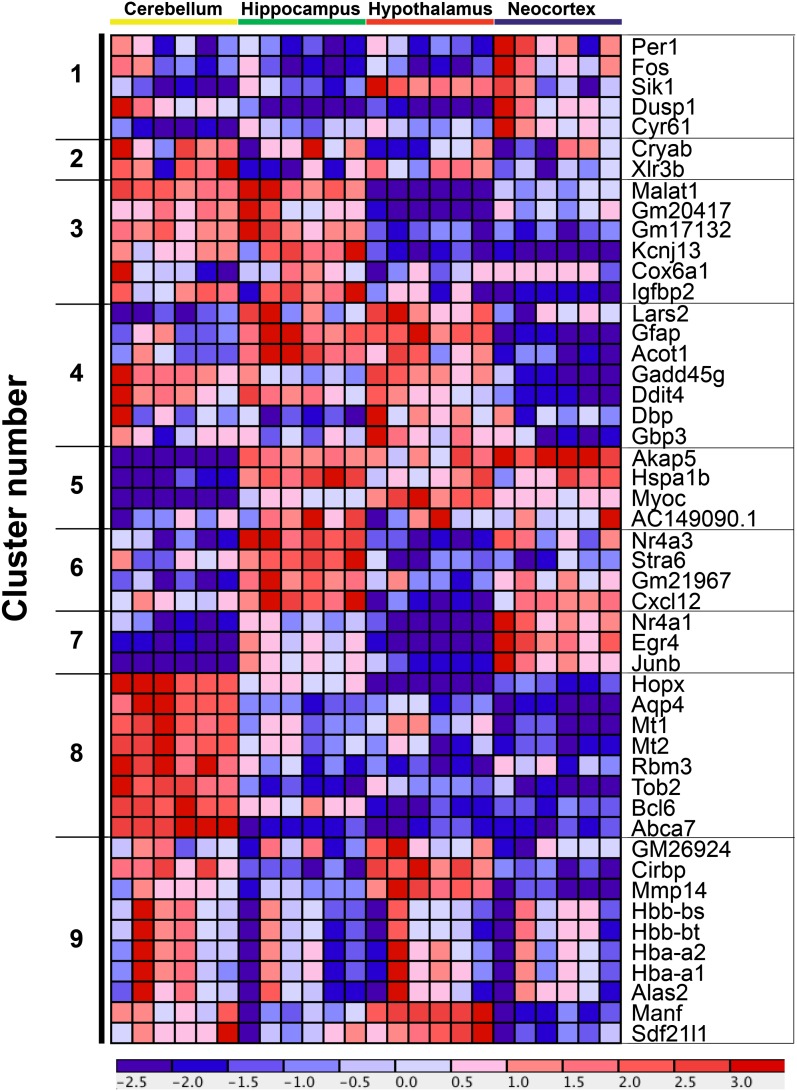
Expression pattern for the 49 genes that are differentially expressed in all four brain regions. Expression profile of the 49 genes found to have differential expression in all four brain regions (see Figure 3A). K-means clustering was performed by rows (the rows are the 49 genes indicated on the right of clustergram), resulting in 9 nodes of the cluster (indicated on the left of clustergram). The algorithm used row normalization and the Euclidean distance metric. The output is visualized with a cluster with red indicating high expression and blue indicating low expression.